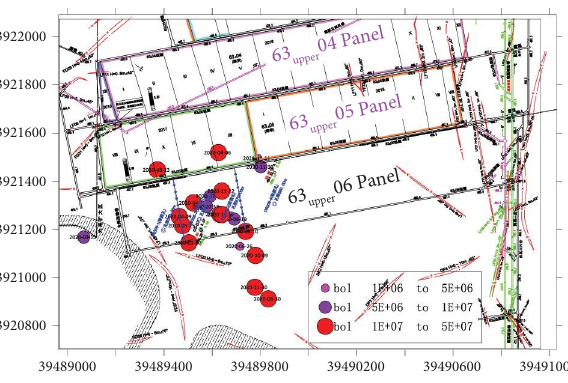
Figure 9: Plan of strong mine tremors distribution.